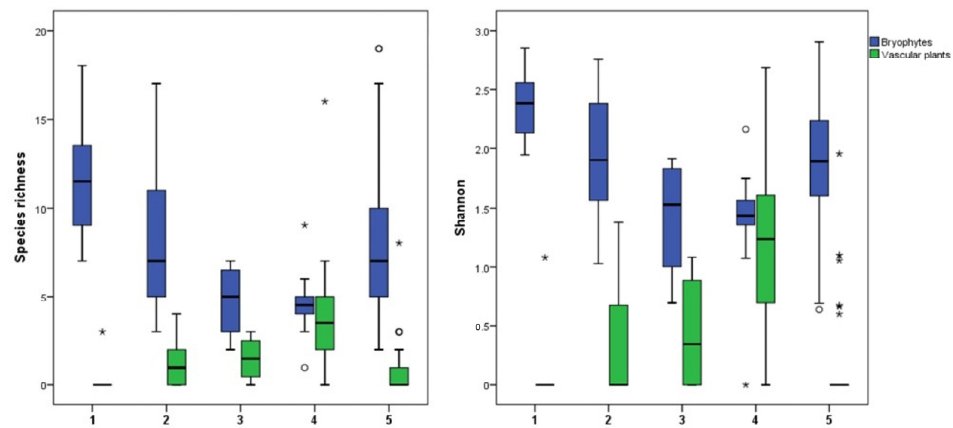
Figure 4. Comparison of bryophyte and vascular plant alpha diversity (species richness and Shannon-Wiener alpha diversity index) between the TWINSPAN groups (outliers: o—”out” values, *—”far out” or extreme values).